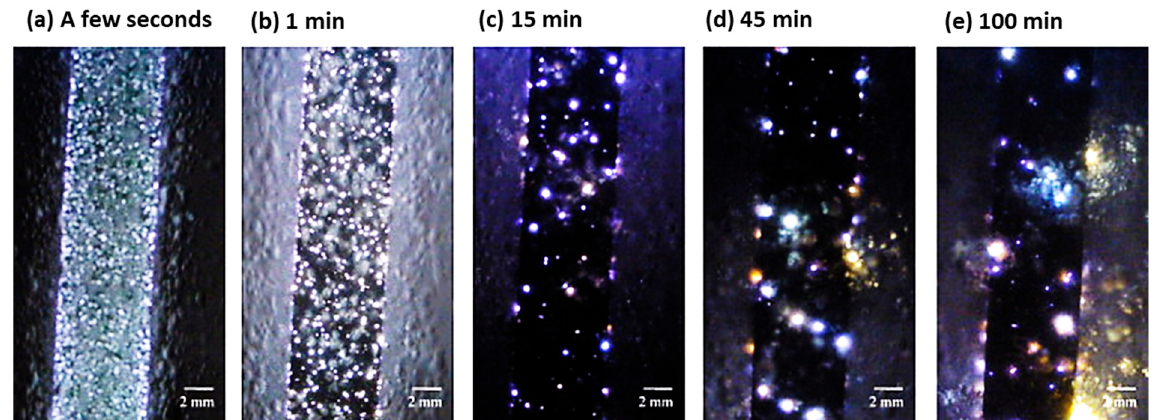
Figure 8. Snapshots during PEO coating depicting size and color of micro discharges produced at durations of ( a ) a few seconds, ( b ) 1 min, ( c ) 15 min, ( d ) 45 min, and ( e ) 100 min. Reproduced with permission from [104]. Copyright Elsevier, 2007.